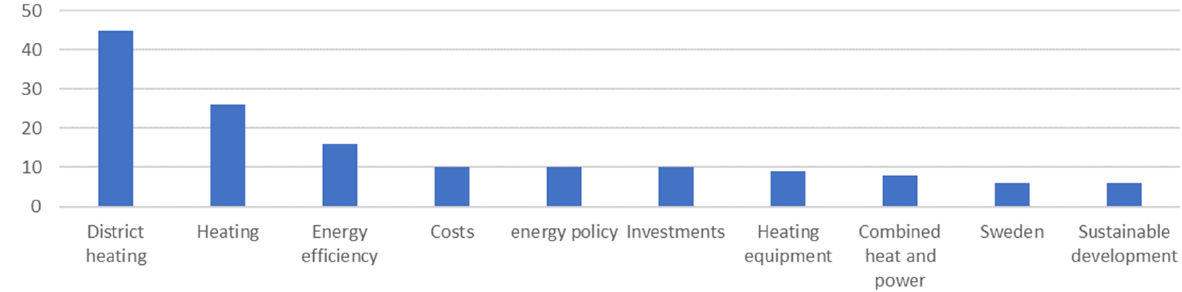
Figure 16. Business—most frequent keywords (horizontal axis) and the number of articles (vertical axis).